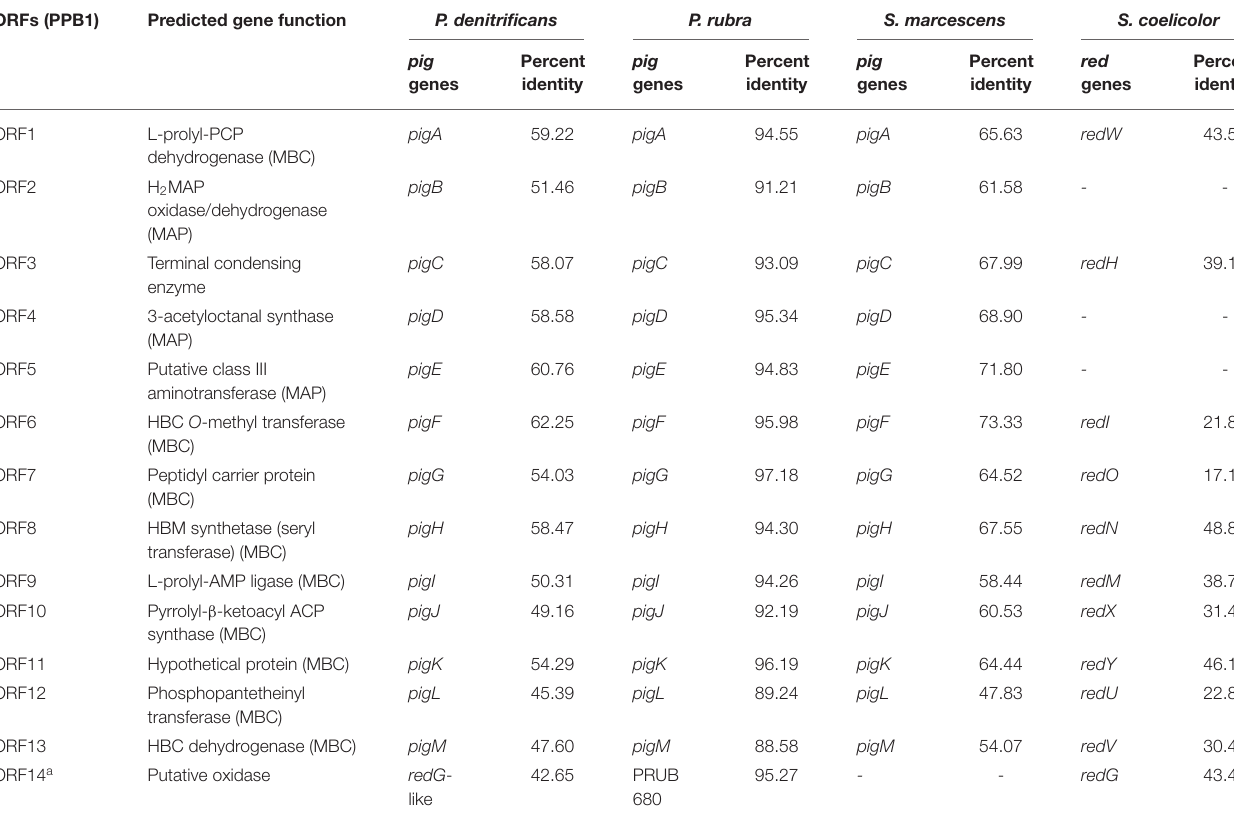
TABLE 8 | Annotated prodiginine biosynthetic gene cluster and their associated homologs. ORFs (PPB1)